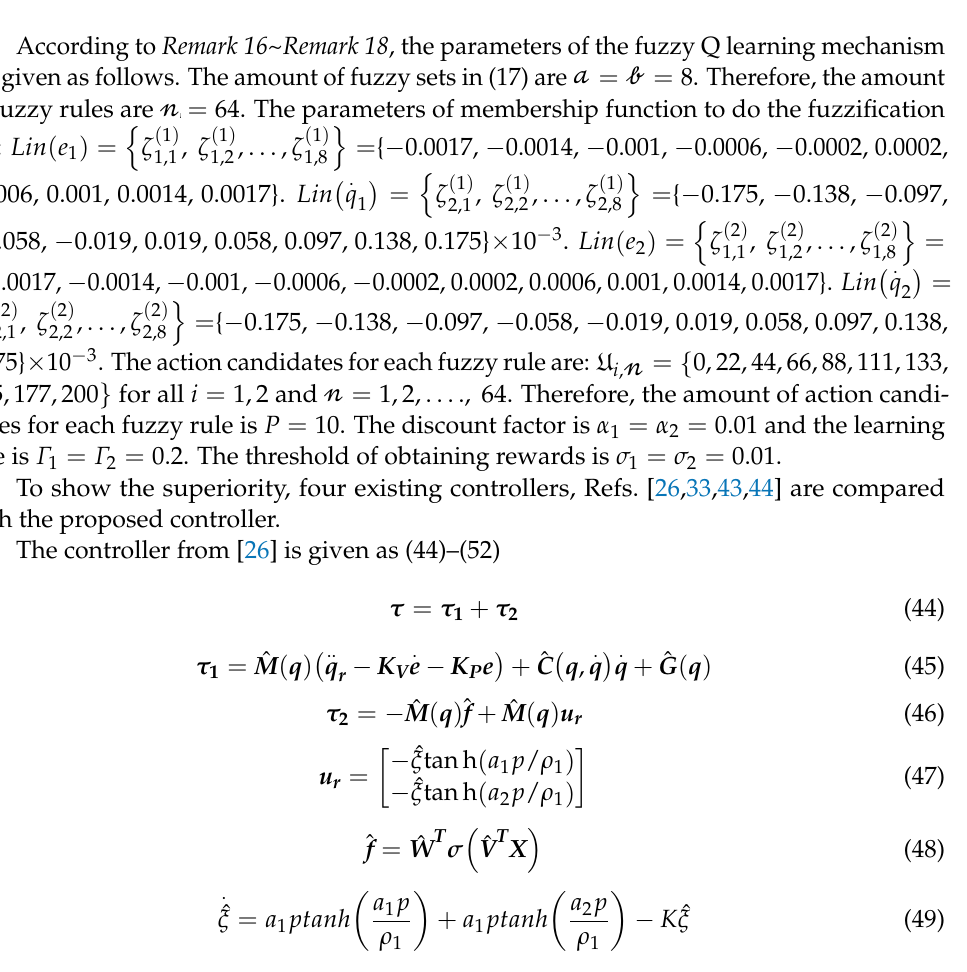
Figure 2. Membership function of fuzzy input of the 𝑖 (cid:3047)(cid:3035) subsystem.